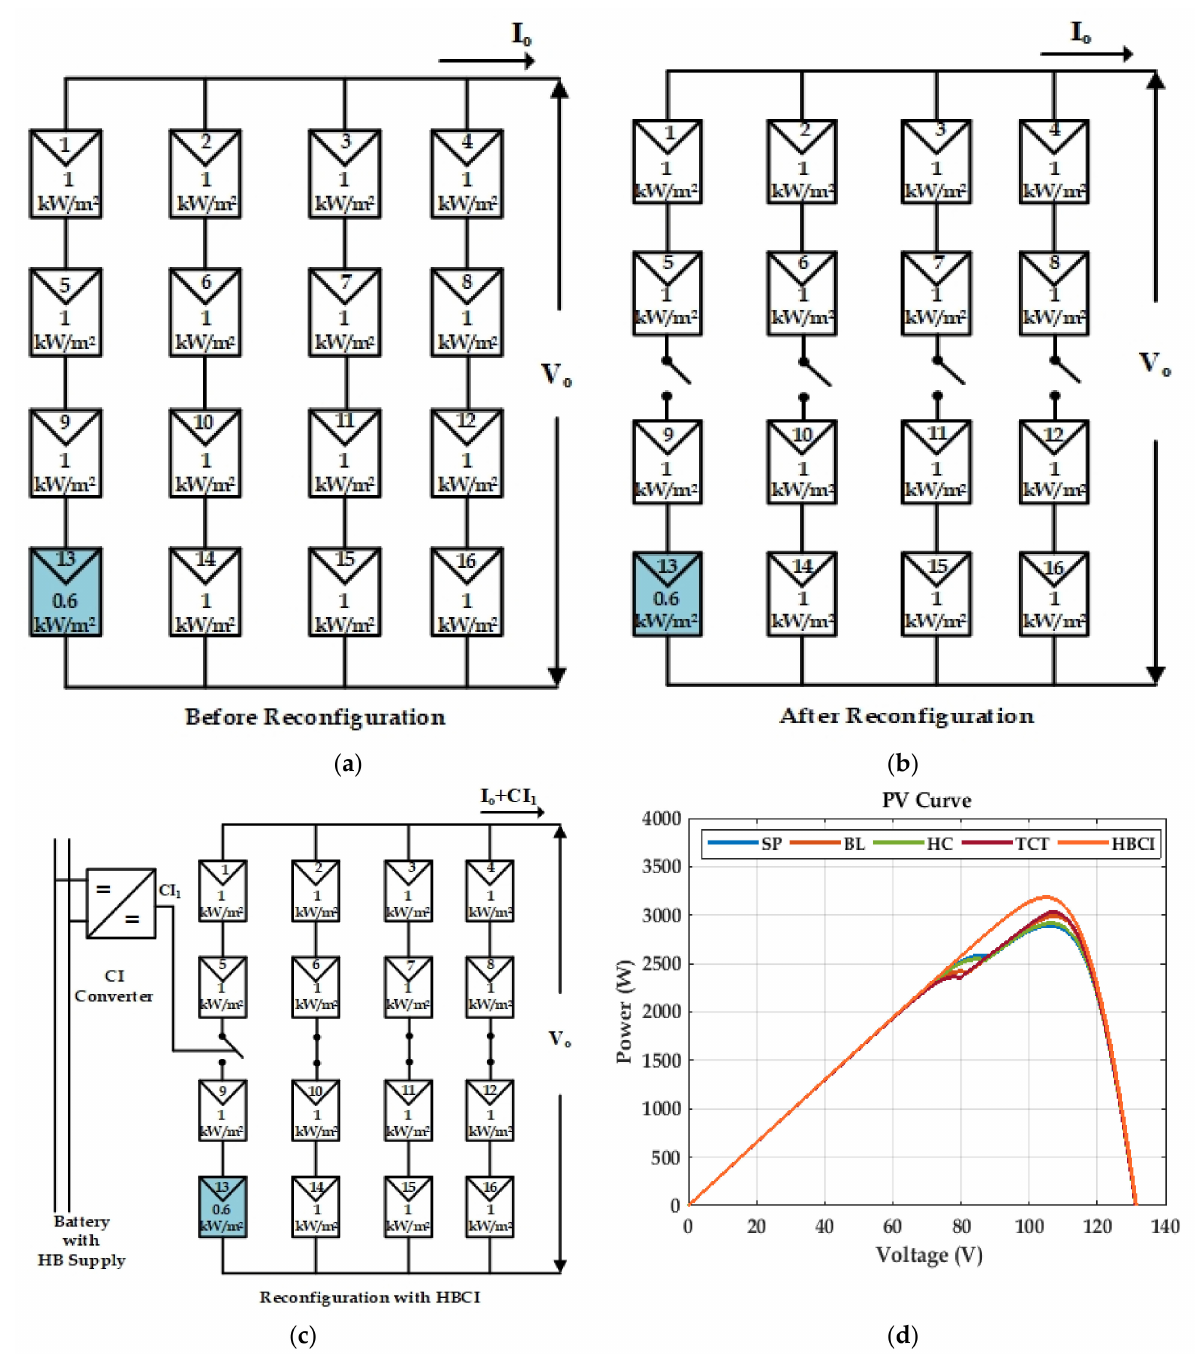
Figure 9. Case 1: single-panel shading: ( a ) the SP array configuration; ( b ) after reconfiguration with HBCI; ( c ) reconfiguration with HBCI; ( d ) PV